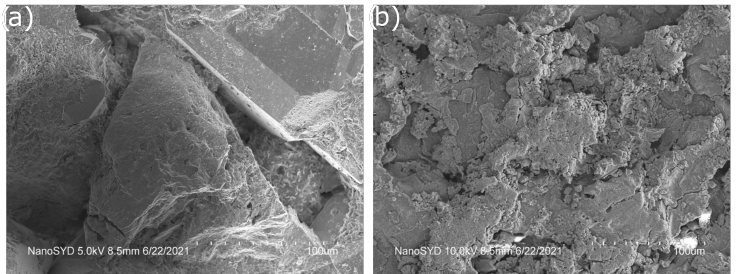
Figure 11. Scanning electron microscopy graphs of Berea sandstone: ( a ) original, ( b ) after TB